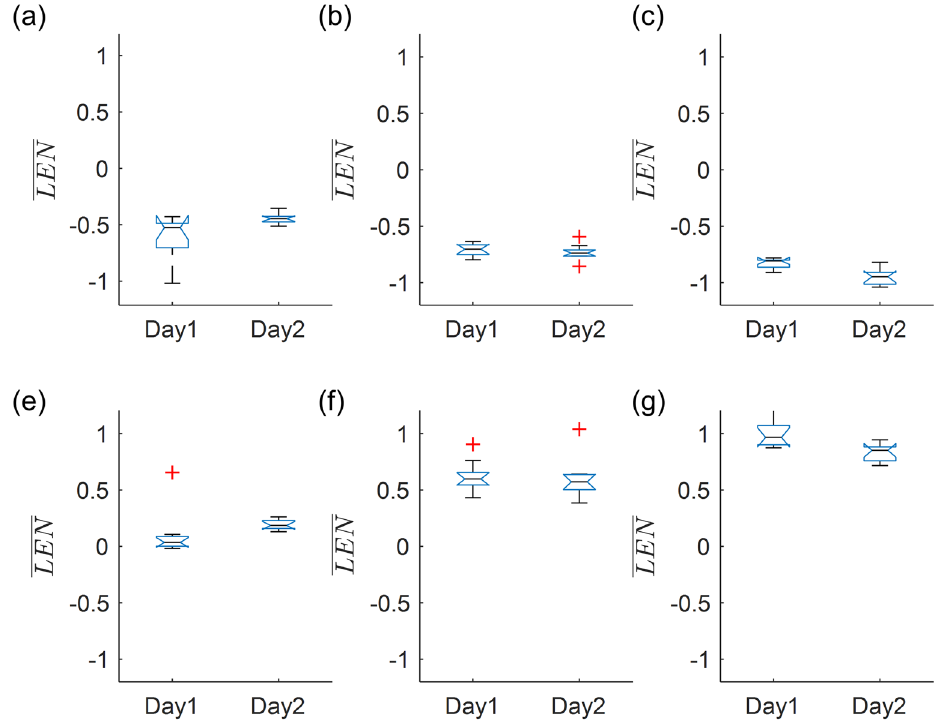
Figure 8. Multi-day comparison of muscle activation during isolated elbow exercises. Red crosses indicate